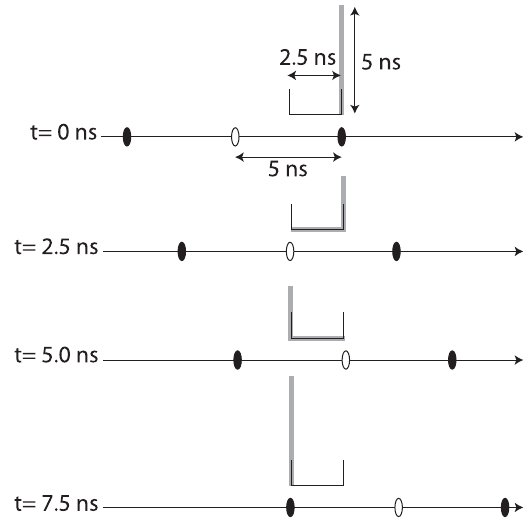
FIG. 6. Schematic time-sequence diagram of circulating and injected bunches, and kicker input pulse for a ring with 100 MHz rf system. The grey thick line represents the input pulse, propagating along the electrode. The closed ellipses represent the circulating bunches, and the open ellipse represents the injected bunch. The kicker efficiency is maximized with a length of 0.75 m (corresponding to a transit time of 2.5 ns, a quarter of the bunch spacing), i.e., the kicker can be fully filled with the input pulse during the transit of the injected bunch without deflecting the circulating